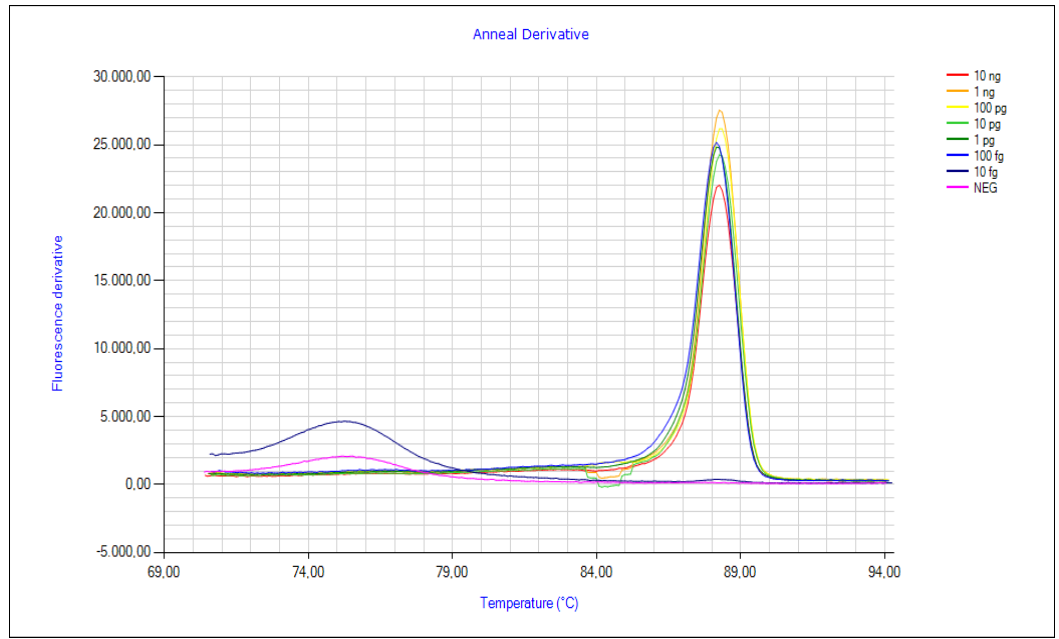
Figure 3. Average quantity of F. fujikuroi in the whole seed obtained by the detection of 34 rice lines with real-time PCR with TaqMan probe in triplicate. The values are the means ± standard deviations (ANOVA, Tukey test, p ≤ 0.05)